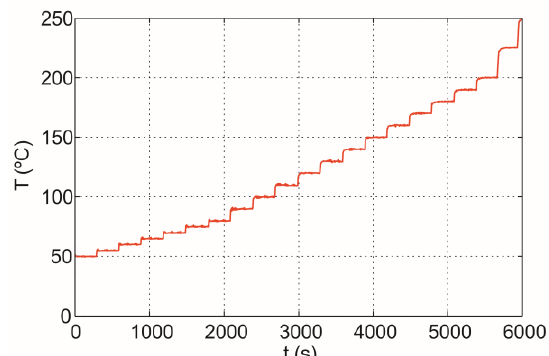
Figure 10. Black-body temperature, T thermal